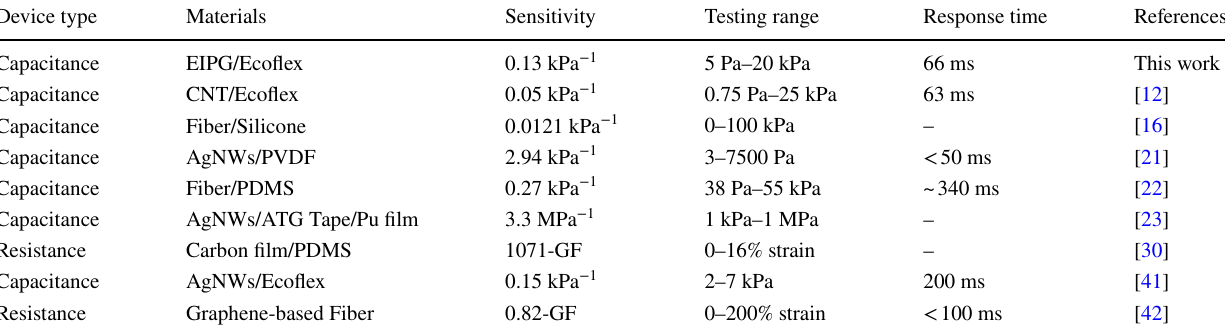
Table 1 Summary of sensitivity and testing range of flexible sensor devices Device